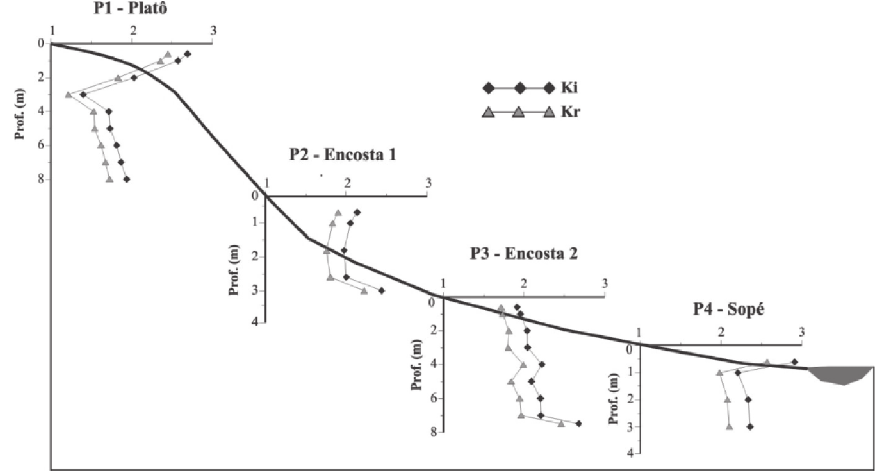
Figura 3. distribuição das relações moleculares Ki (sio 2 /al2o 3 ) e Kr [sio 2 /(al 2 o 3 +Fe 2 o 3 )] nos pontos estudados da microbacia.